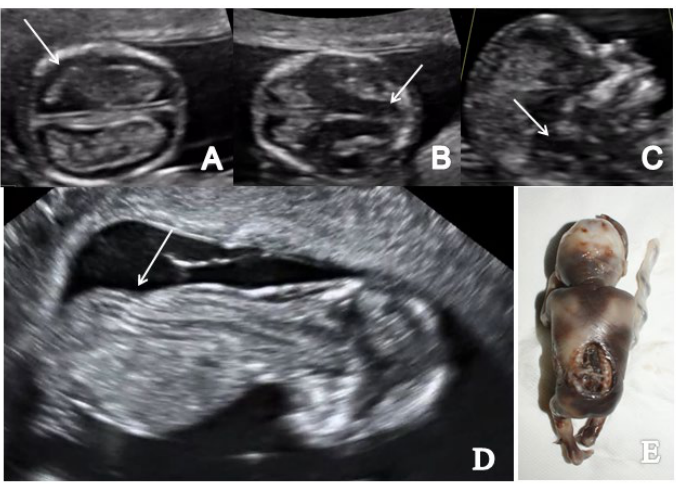
Figure 3. A case of OSB diagnosed at 12 weeks + 3 days (Case 1): ( A ) transverse view of enlarged choroid plexus (the ‘dried up’ brain sign, arrow); ( B ) displacement of mesencephalon and aqueduct of Sylvius and deformation against occipital bone (‘the crash sign’, arrow); ( C ) mid-sagittal view of the fetal face showing the displacement of BS, which appears thicker (arrow) and with an increased BS/BSOB ratio; ( D ) sagittal view by transvaginal approach demonstrating the abnormal aspect of the spine—kyphoscoliosis (arrow); ( E ) specimen presentation of OSB after medical TOP.